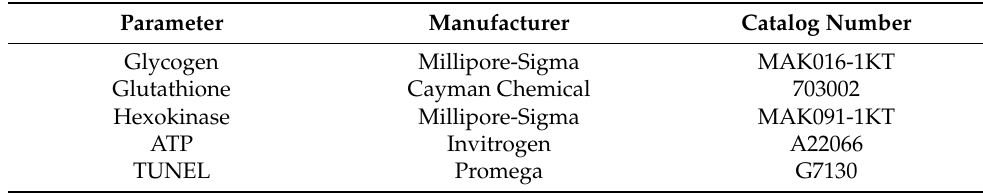
Table 2. Biochemical assay